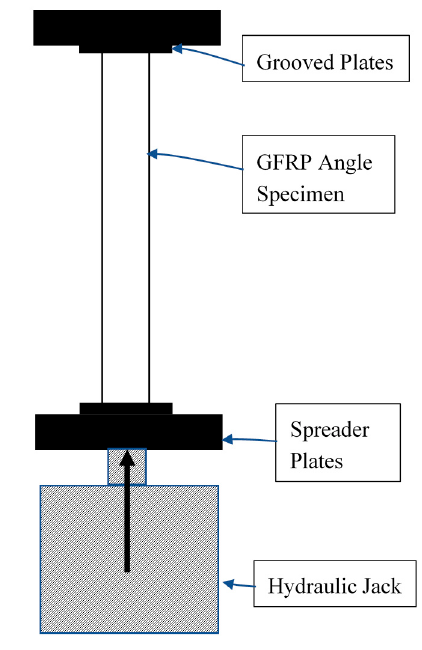
Figure 4. Experimental loading setup.